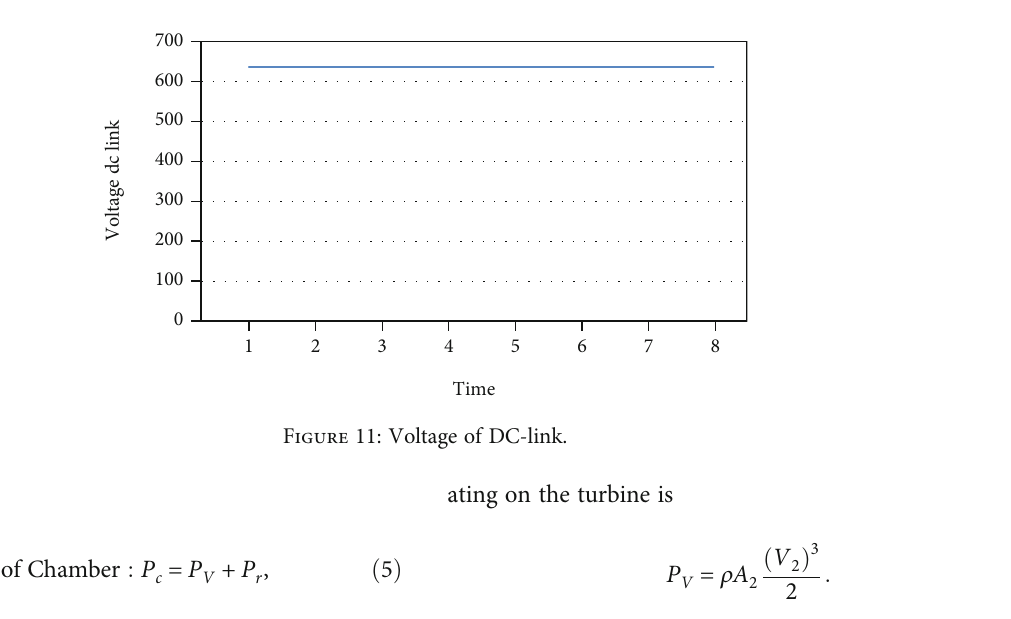
Figure 10: Distributed power by a hybrid PV-wave system.